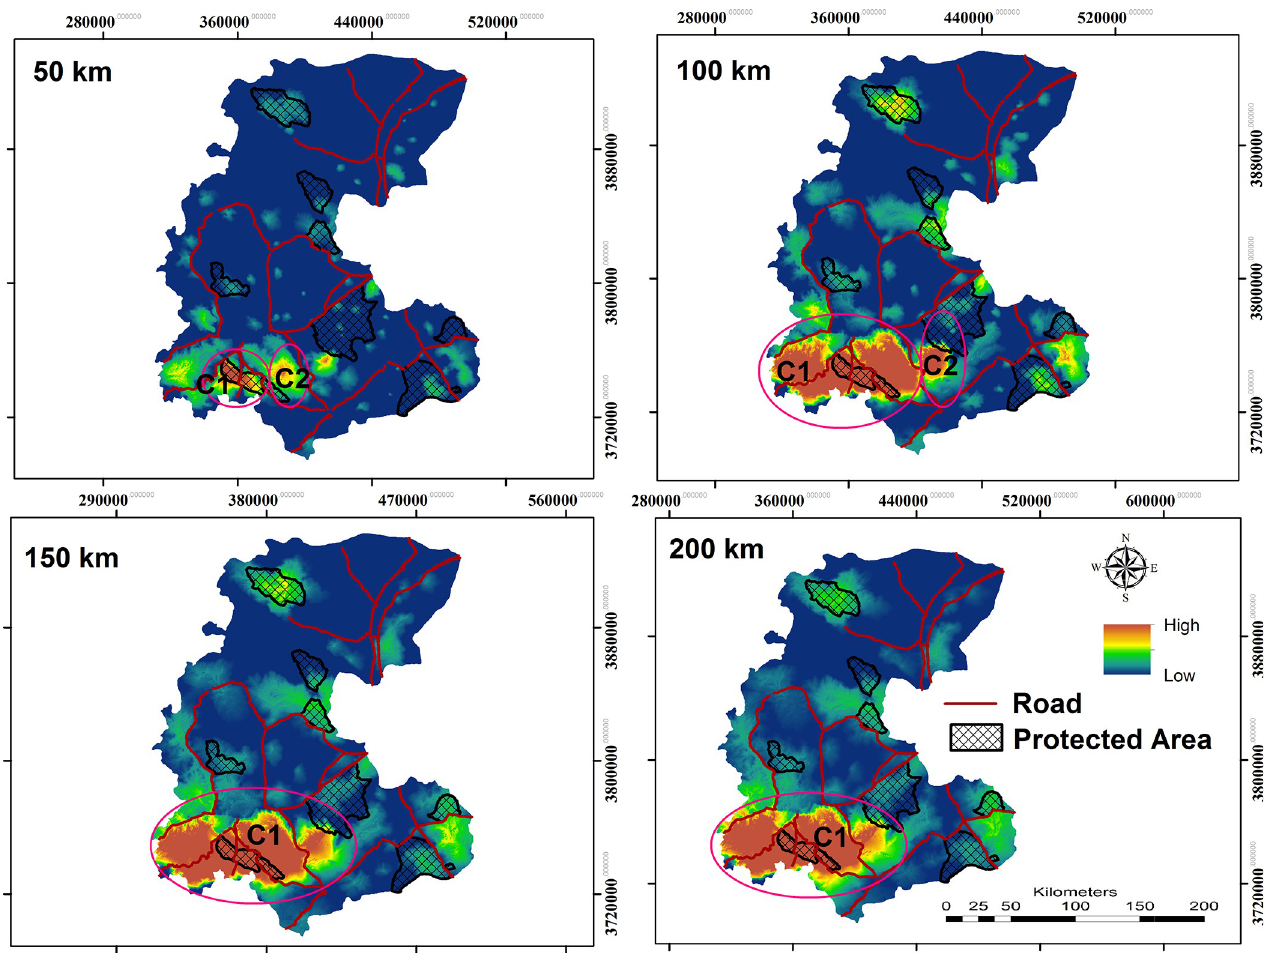
Fig 4. Golden Jackal core areas at dispersal ability 50, 100, 150 and 200 km respectively and network of CAs and roads. Republished from [http://www.frw. ir] under a CC BY license, with permission from [Forest, Range, Watershed Management Organization of Markazi province (IFRWO)], original copyright [2021]. Republished from [https://markazi.doe.ir/] under a CC BY license, with permission from [Markazi Province Office of Department of Environment (DOE)], original copyright [2021].